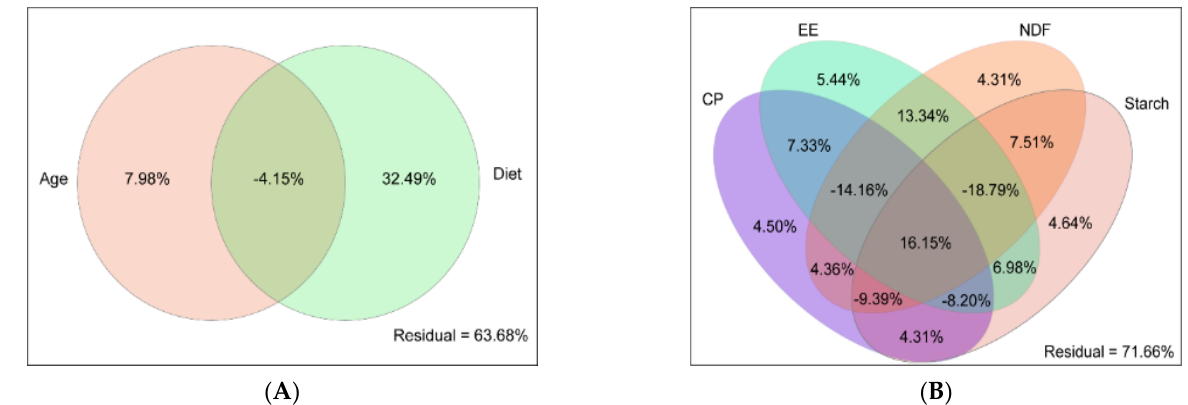
Figure 3. Variation partitioning approach (VPA) analysis the relative importance of ( A ) diet and age, ( B ) CP, NDF, starch, and EE on rumen bacteria composition. CP: crude protein; NDF: neutral detergent fiber; EE: ether extract.